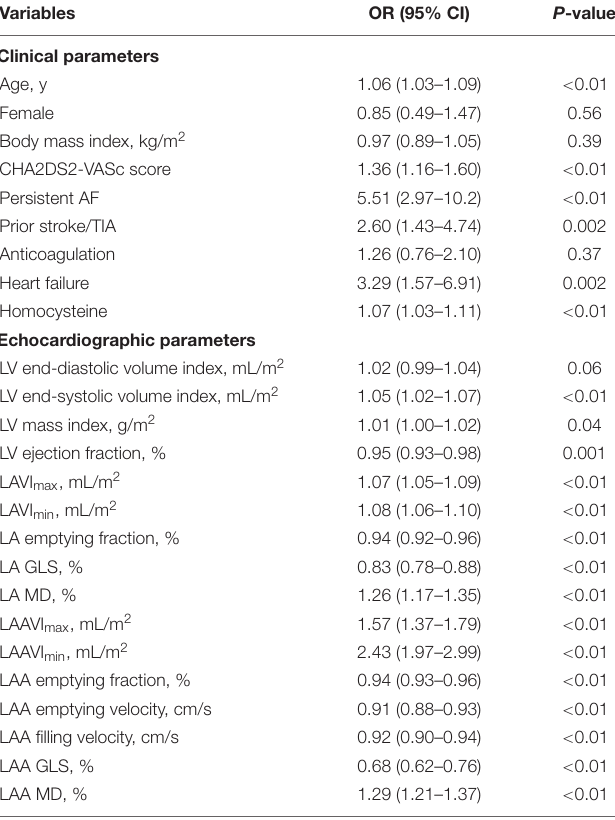
TABLE 3 | Univariable analyses of associations with LAA dense SEC or thrombus.